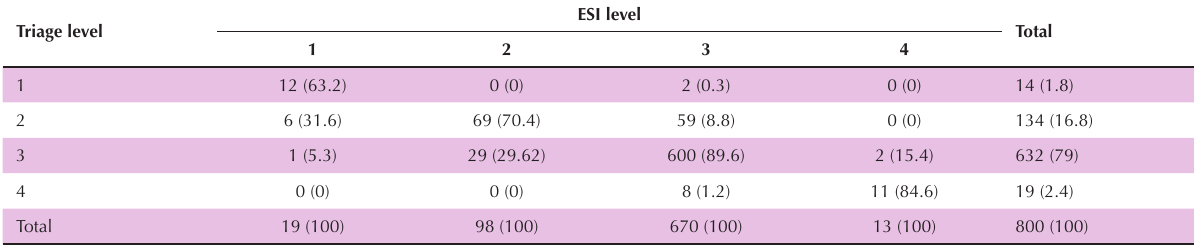
Table 1. Triage concordance with ESI Triage